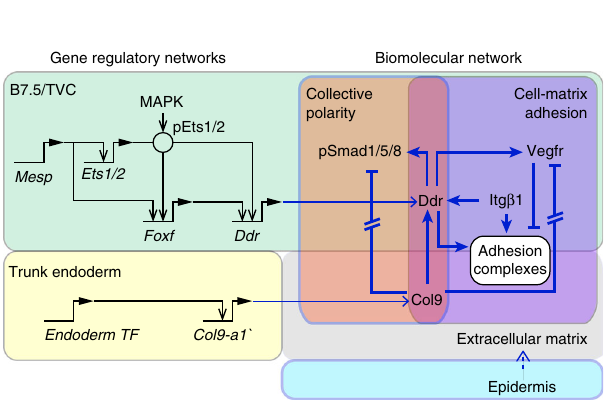
Fig. 7 Integration of transcriptional and biomolecular networks to produce directional migration. Intersection of fate-speci fi cation through the cardiac GRN in the B7.5/TVC lineage (green) and downstream cellular effectors regulating ECM adhesion and polarity (purple and orange) regulates adhesion and detachment of TVCs to ensure directional migration. Black arrows show transcriptional regulation, blue arrows show activity regulation Gene regulatory connections are derived from 14 – 16,18,21 . Exposure to extracellular Col9-a1 activates Ddr while blocking Vegfr activity. Additionally, Int β 1 contributes to promotion of Ddr activity and adhesion. Solid blue lines show interactions con fi rmed in this